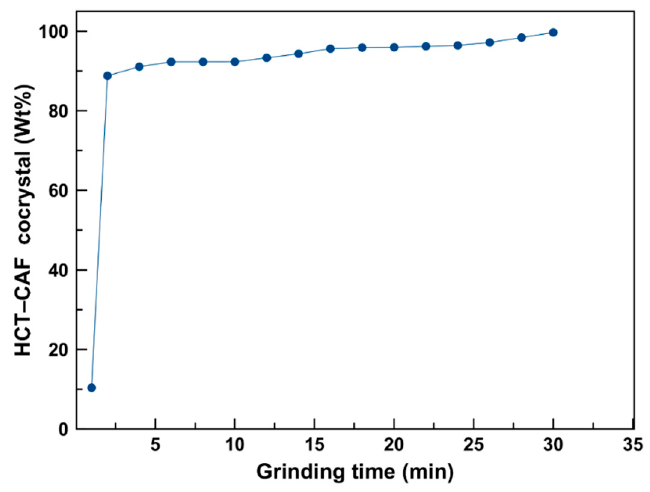
Figure 3. HCT–CAF cocrystal formation during cogrinding at room temperature.